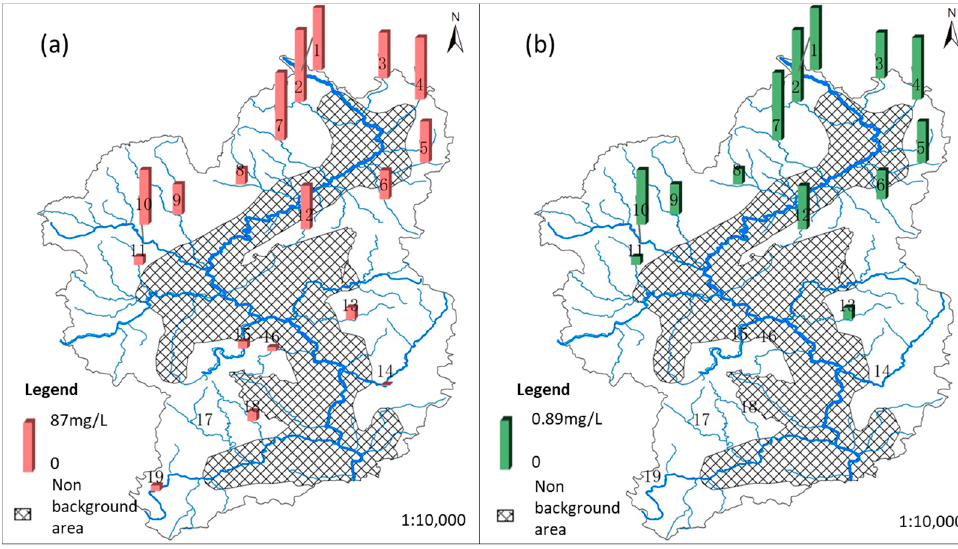
Figure 5. Distribution of values exceeding the standard (standard value subtracted from monitoring value). ( a ) Chemical oxygen demand; ( b ) ammonia value). ( a ) Chemical oxygen demand; ( b ) ammonia nitrogen.